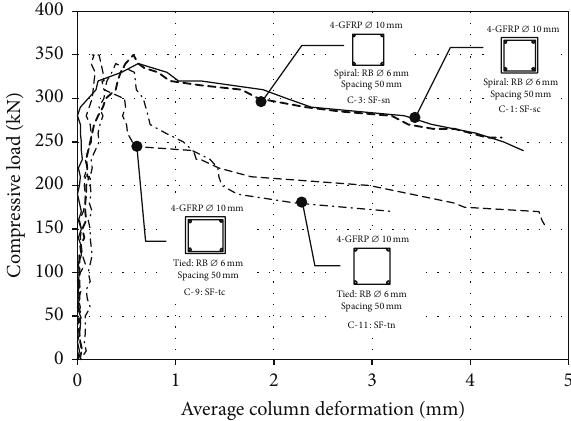
Figure 9: Comparison of load-strain curves with various types of lateral